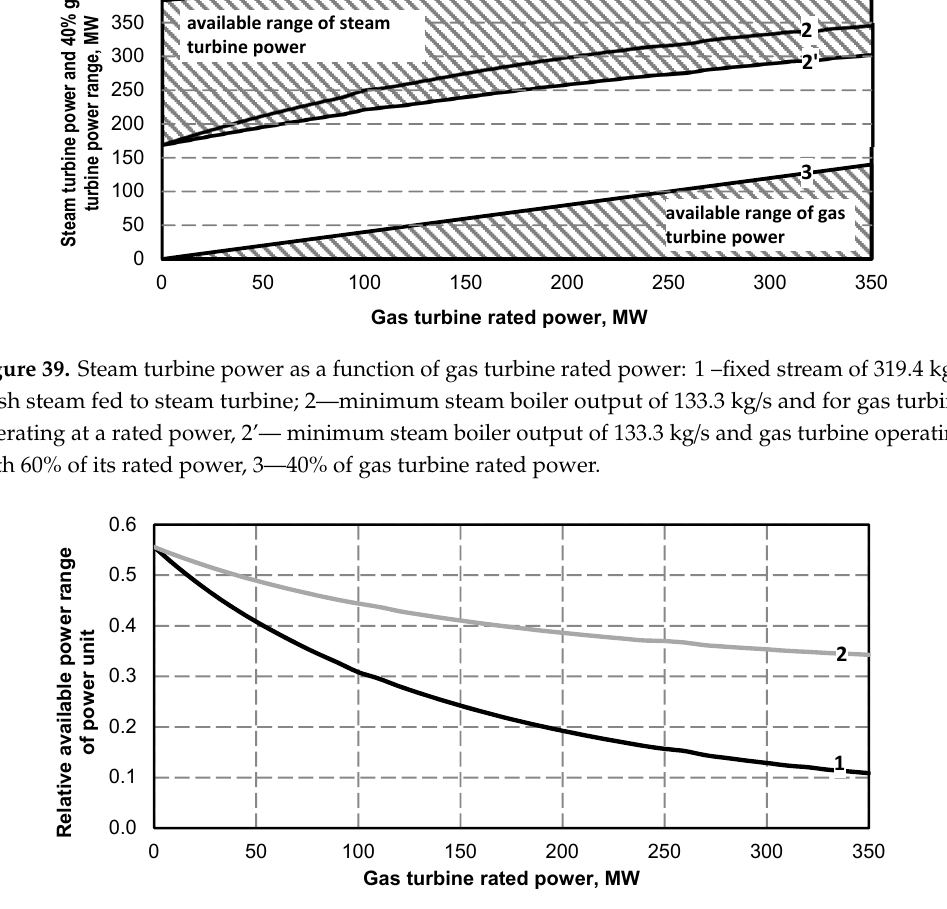
Figure 40. Relative available power range of power unit as a function of gas turbine rated power: 1—gas turbine operating at its rated power, 2—gas turbine operating with variable power ranging from 100% to 60% of its rated power.